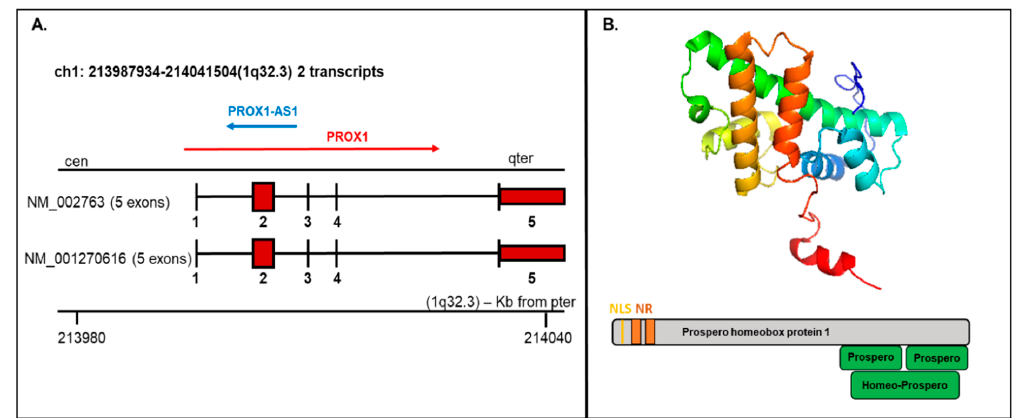
Figure 2. Prospero homeobox 1 (PROX1) mRNA/protein structure. ( A ) The PROX1 transcript presents two variants (1-NM_002763 and 2-NM_001270616; the first variant represents the longer transcript; both options 1 and 2 encode the same protein); mRNA includes five exons and four introns. The structure is available on http://atlasgeneticsoncology.org/Genes/GC_PROX1.html ( B ) Top—Protein structure-based on the PDB model (ID: 2LMD; graphical visualization was made in PyMOL), bottom—the schematic protein structure with the nuclear localization signal (NLS) and nuclear receptor (NR) boxes at the N-terminus and prospero and homeobox domains on C-terminus.